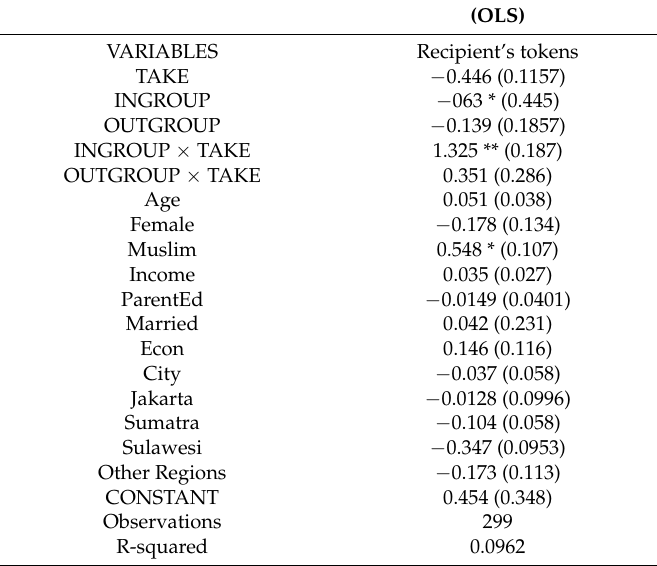
Table 4. OLS regression of allocations to